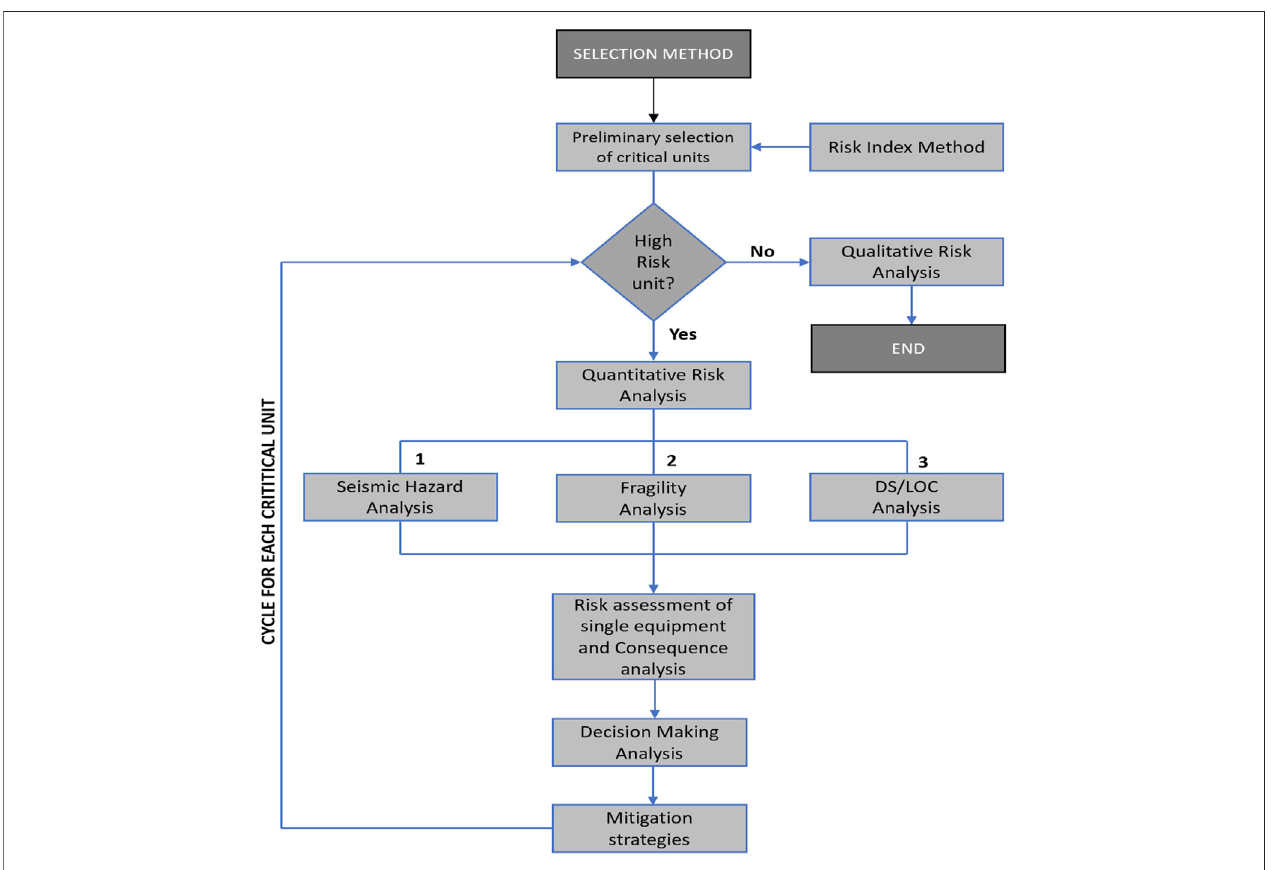
FIGURE 1 | Flowchart of the selection method of critical units in major-hazard plants.